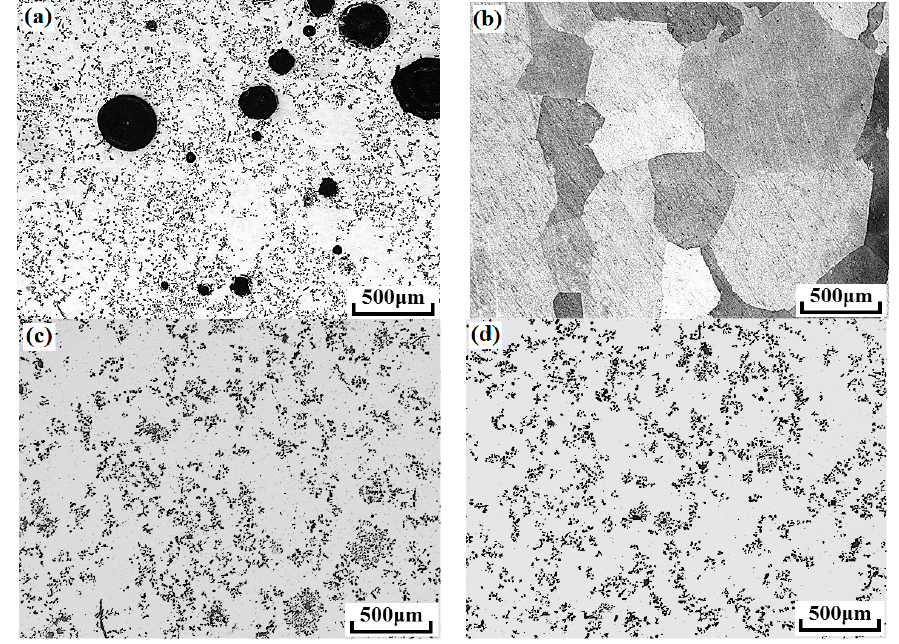
Figure 7. Solidification structure of Cu ‐ 14Fe alloys, without AMF: ( a ) top, ( b ) bottom; with AMF: ( c ) top, ( d ) bottom.